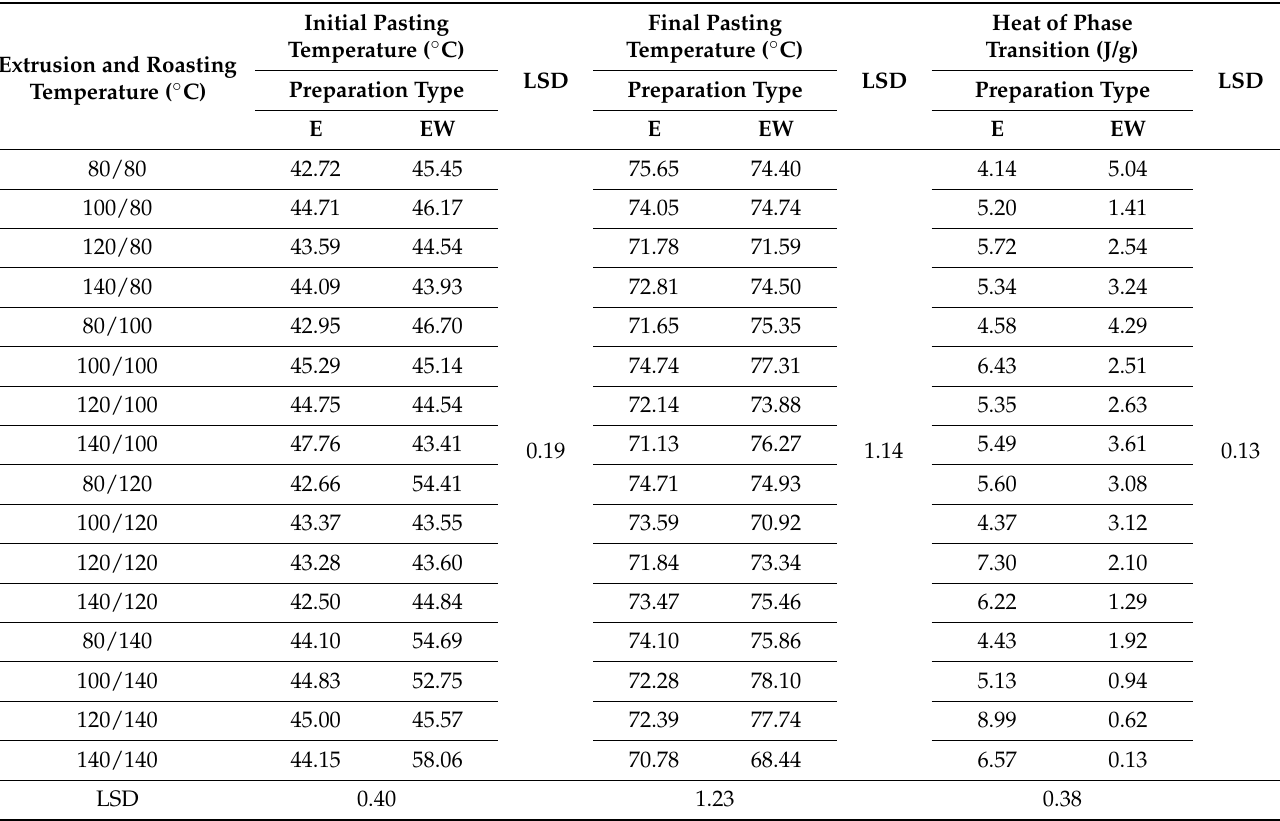
Table 1. Thermal characteristics of extruded and roasted starch (E) and of starch extruded with apple distiller wastewater and roasted